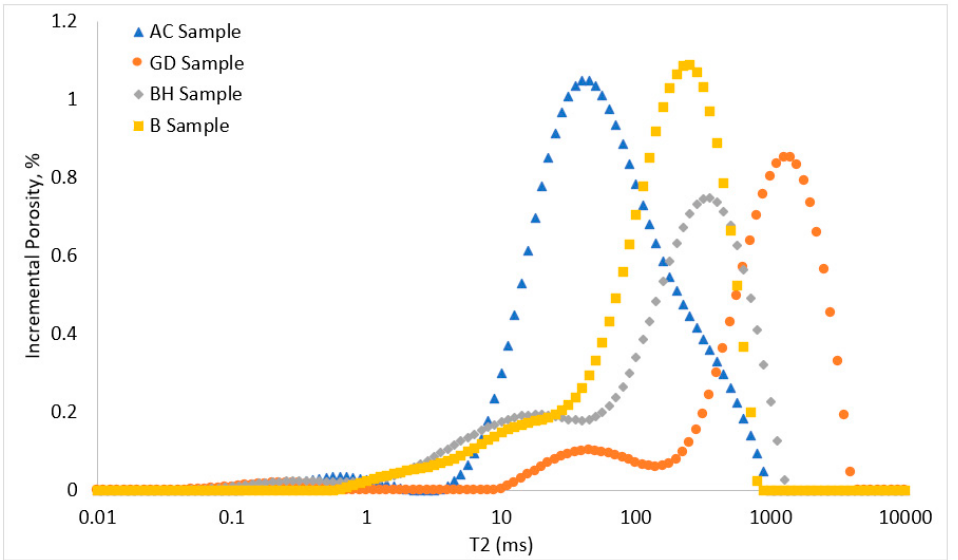
Figure 8. NMR T 2 spectrum of the used core samples when fully saturated with water ( S w = 100%).